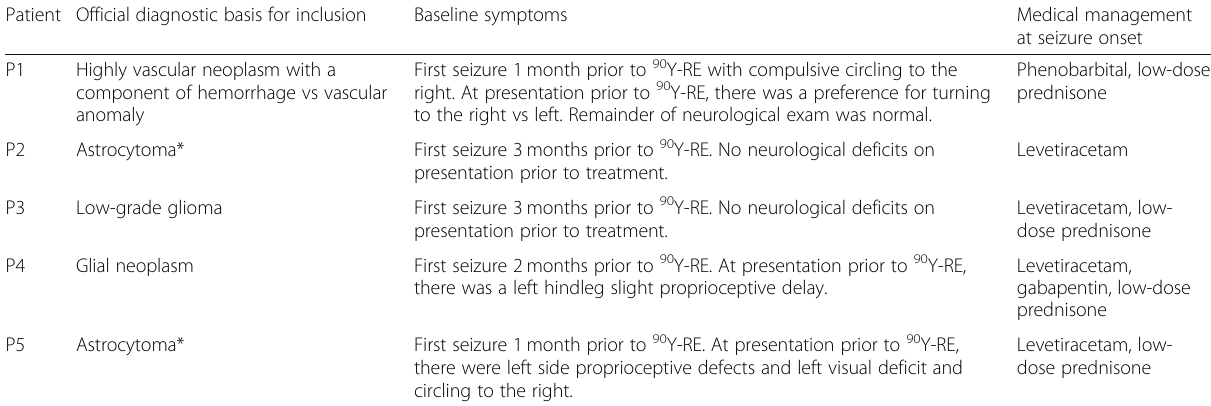
Table 3 Summary of pre-treatment imaging diagnosis, baseline symptoms, and pre-treatment medical management in P1 – P5 Patient Official diagnostic basis for